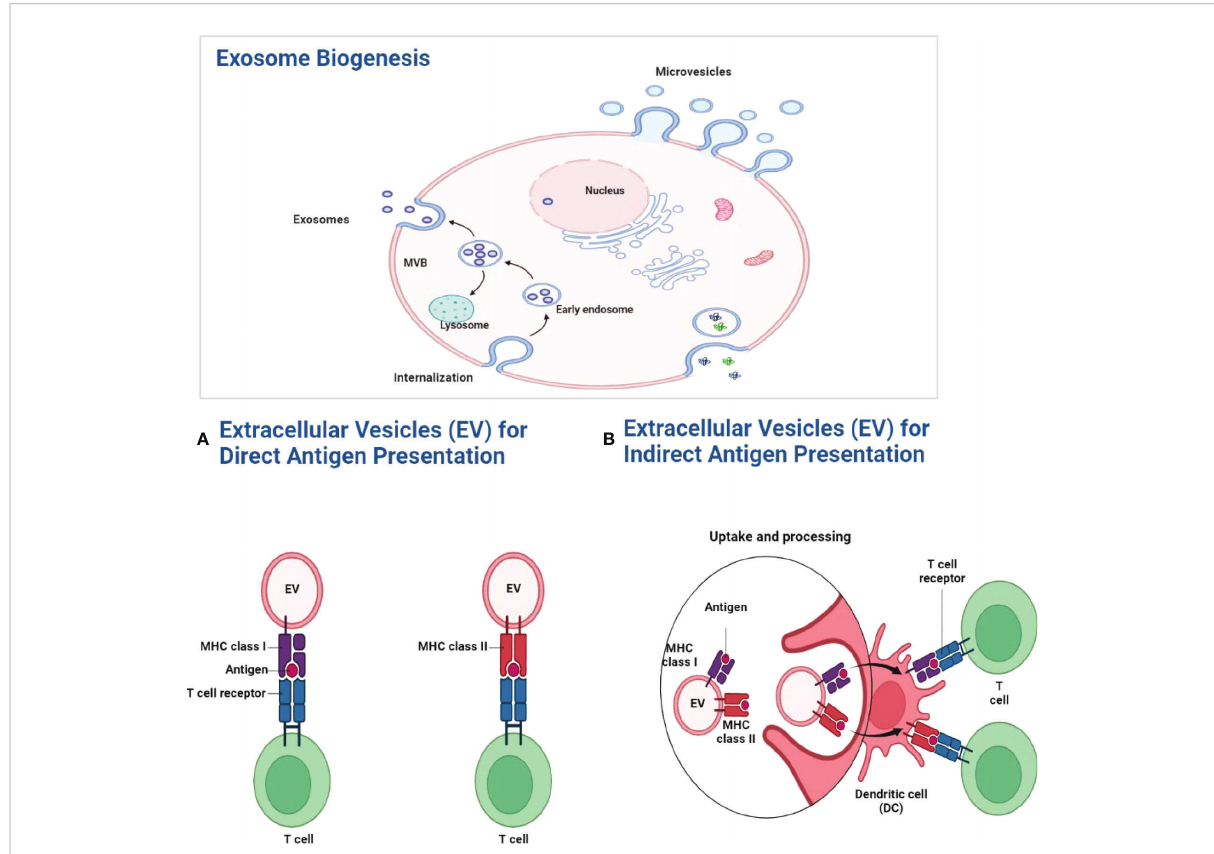
FIGURE 2 Exosome biogenesis. The MVB gradually fi lls with intraluminal vesicles as a consequence of inward budding. And these multivascular entities are capable of doing two tasks simultaneously. One of these two pathways may allow MVBs to combine with lysosomes and break down their contents. Alternatively, it may follow the exocytic route, fusing with the plasma membrane to discharge its contents into the extracellular environment. ILVs are referred to as “ exosomes ” after they are discharged into the extracellular environment. (A) Antigen presentation by exosomes. By expressing MHC molecules on their surface, exosomes may directly transport antigens to T cells. Exosome-associated peptide- MHC complexes are densely localized in the DC plasma membrane for ef fi cient immunological synapses when exosomes bind to the surface of DCs. (B) Exogenous antigens are digested and presented onto MHC-I molecules by phagocytic antigen-presenting cells, which causes speci fi c CD8+ T lymphocytes to cross-present MHC class I-restricted antigens